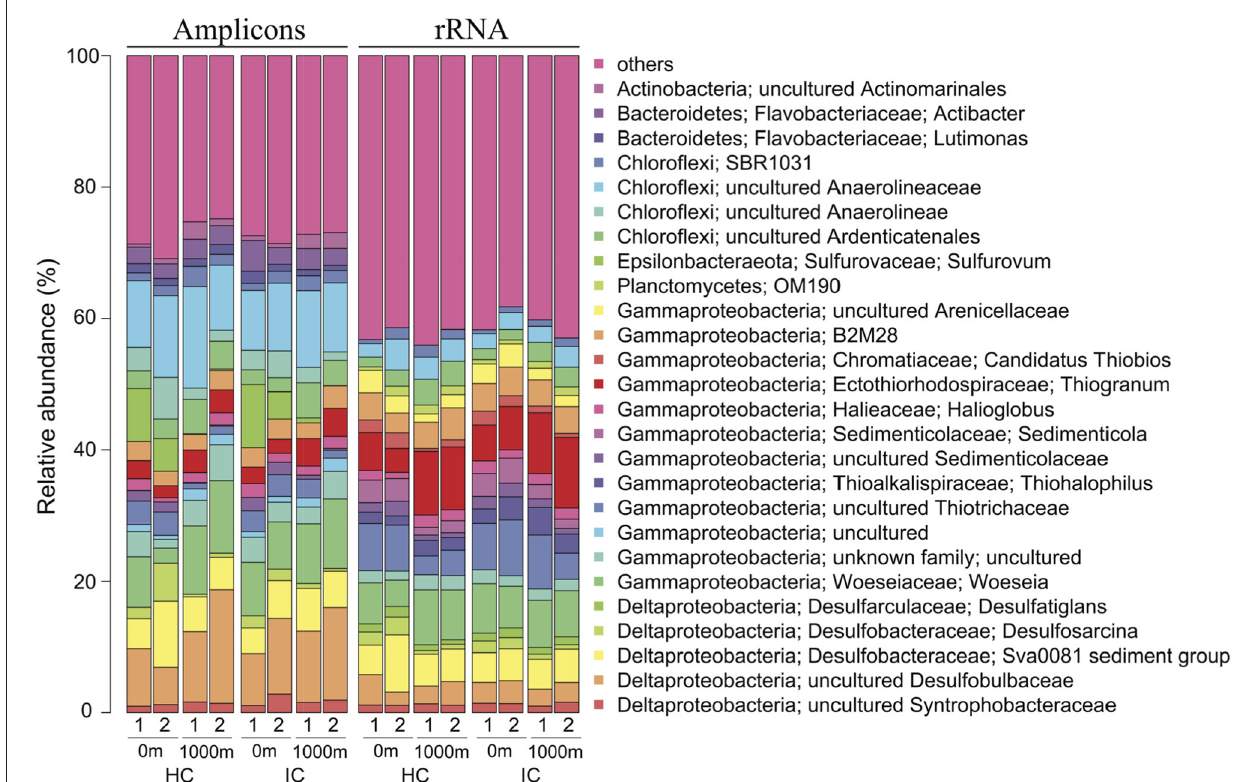
and Supplementary Table 9